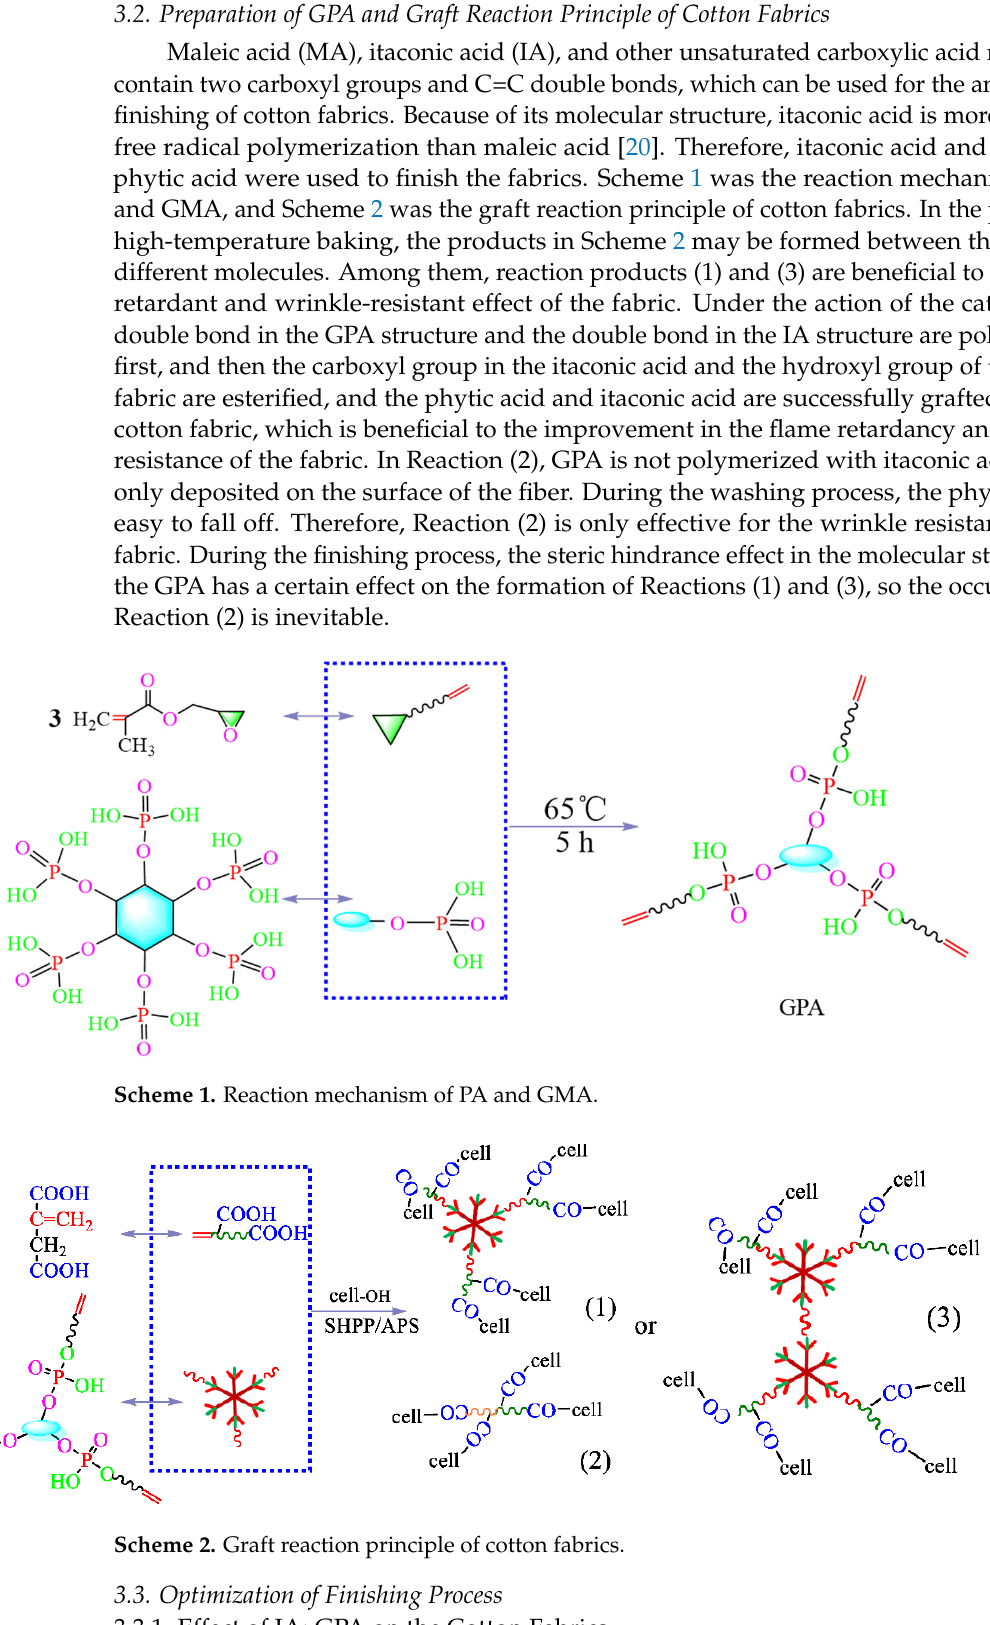
Figure 1. Infrared spectra of the GPA